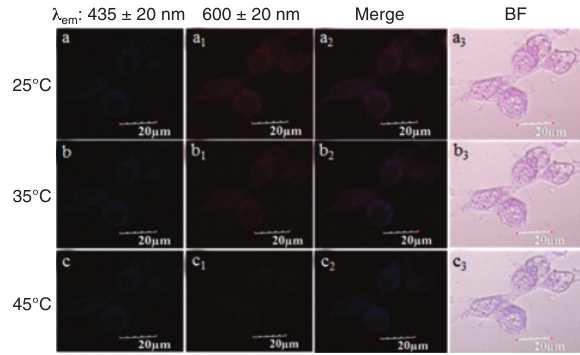
Figure 20: Confocal fluorescence images, merged images and bright-field (BF) images of fixed 293T cells with internalized carbon dot/gold nanocluster hybrids at different temperatures = 365 nm). Reproduced with permission from Wang et al. (2016). ( λ ex